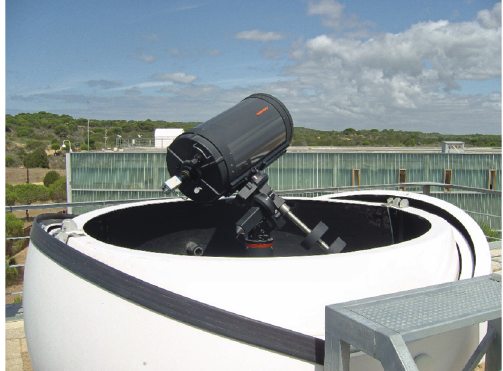
Figure 3: Image of one of the two 14-inch SC telescopes integrating the impact flashes detection